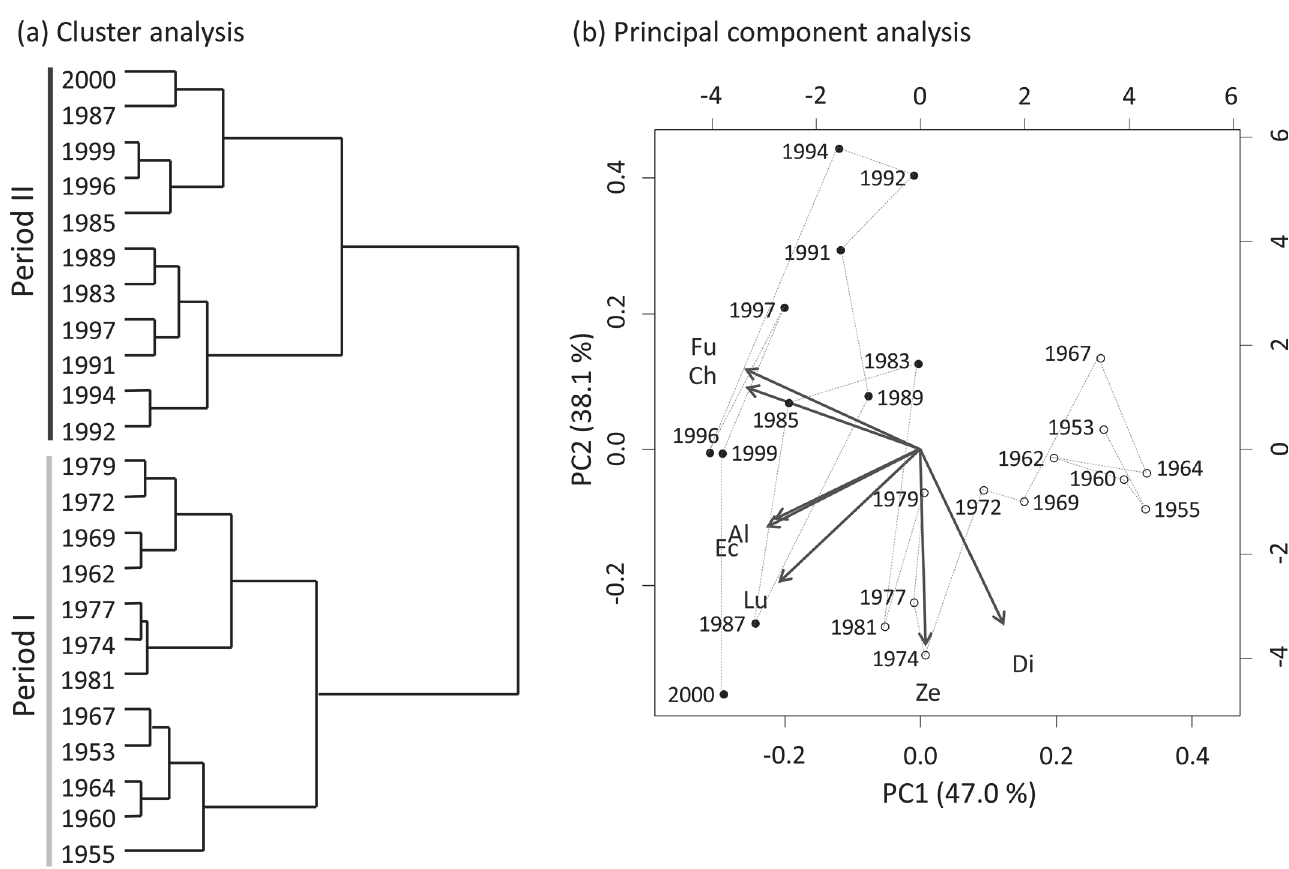
Fig 4. Result of the cluster analysis (a) and principal component analysis (b) using fluxes of fossil pigments. ( a) Two distinctly divided periods are denoted by a gray line (period I) and dark gray line (period II). ( b ) Chronological years of sediment layers are denoted by open circles (period I) and closed circles (period II), and projection of vector variables of fossil pigments are denoted by gray arrows with abbreviations of pigment names, Ch: chlorophyll- a and pheophytin- a , Fu: fucoxanthin, Di: diatoxanthin, Al: alloxanthin, Lu: lutein, Ze: zeaxanthin, and Ec: